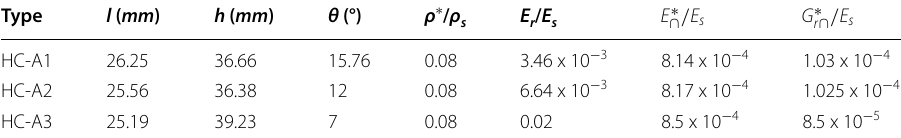
Table 1 Honeycomb (HC) spokes mechanical and geometrical properties